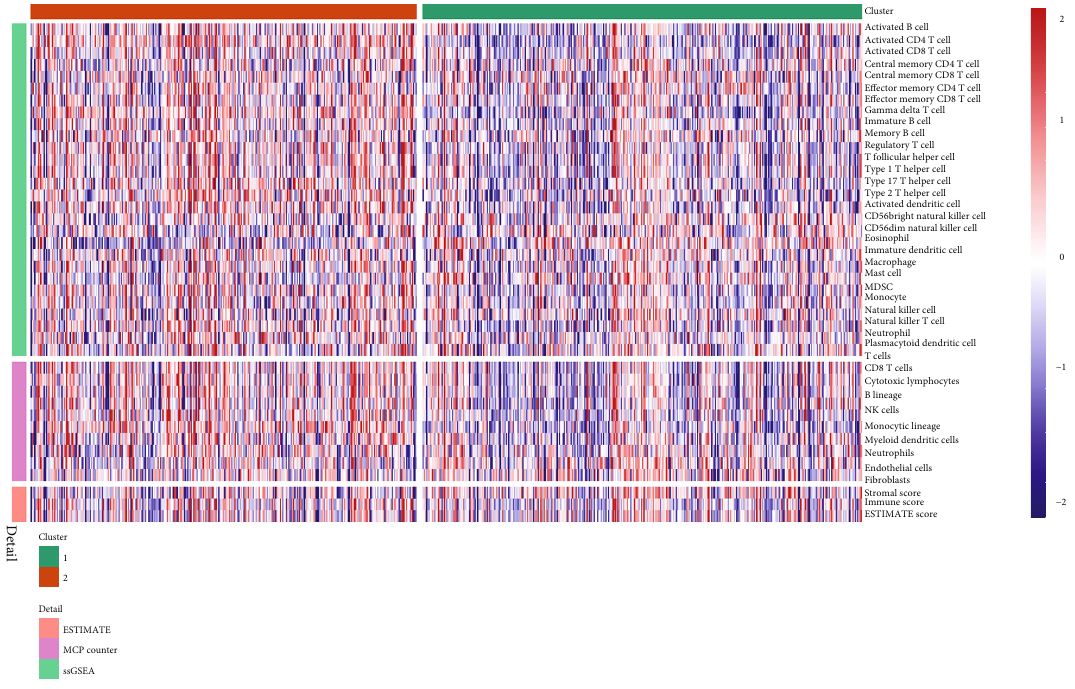
Figure 3: Comparison of StromalScore, ImmuneScore, and ESTIMATEScore between the two clusters of breast cancers in the TCGA-BRCA cohort (a). Evaluation of the in fi ltrating scores of 10 immune cells between the two clusters of breast cancer in the TCGA-BRCA cohort (b). Comparison of ssGSEA scores between the two clusters in TCGA cohort (c). The heat map shows the three immune scores between the two clusters (d). Adjusted p values: ∗ p < 0 : 05 ; ∗∗ p < 0 : 01 ; ∗∗∗ p < 0 : 001